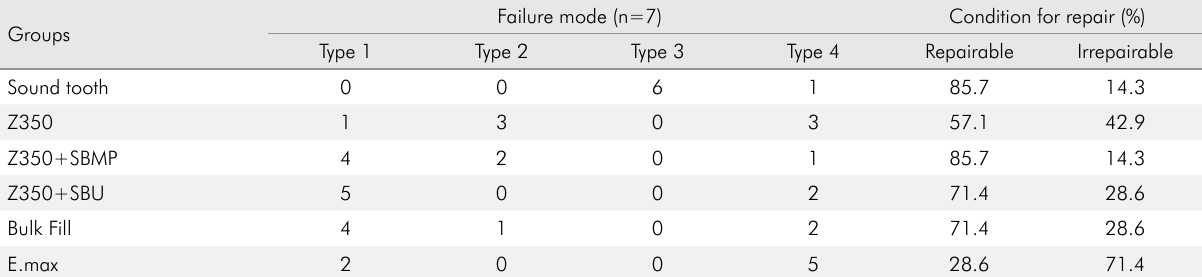
Table 3. Results for the failure mode obtained for all samples tested in the study, which were ranked according to their condition for repair, in